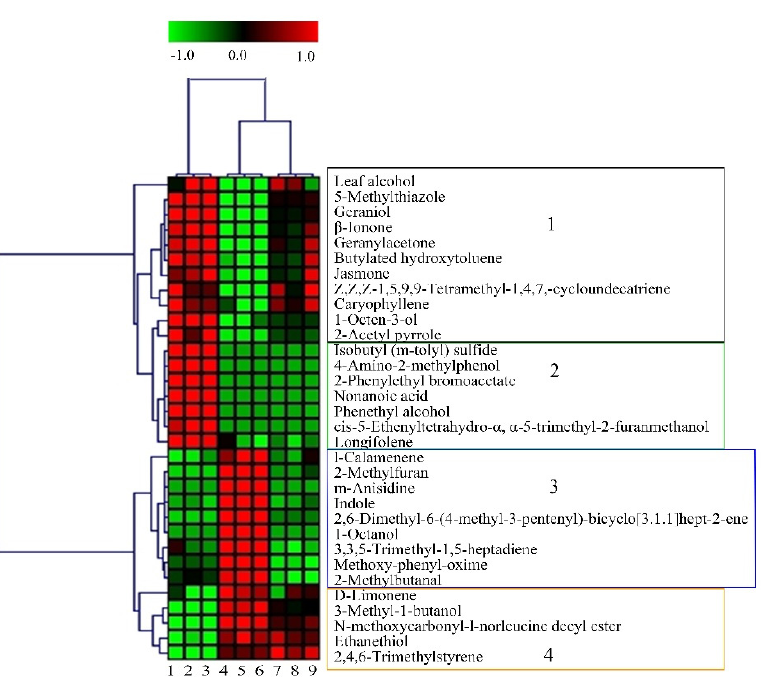
Figure 3. HCA analysis of 32 key compounds of green tea produced in different seasons (1–3 are spring tea, 4–6 are summer tea, 7–9 are autumn tea).